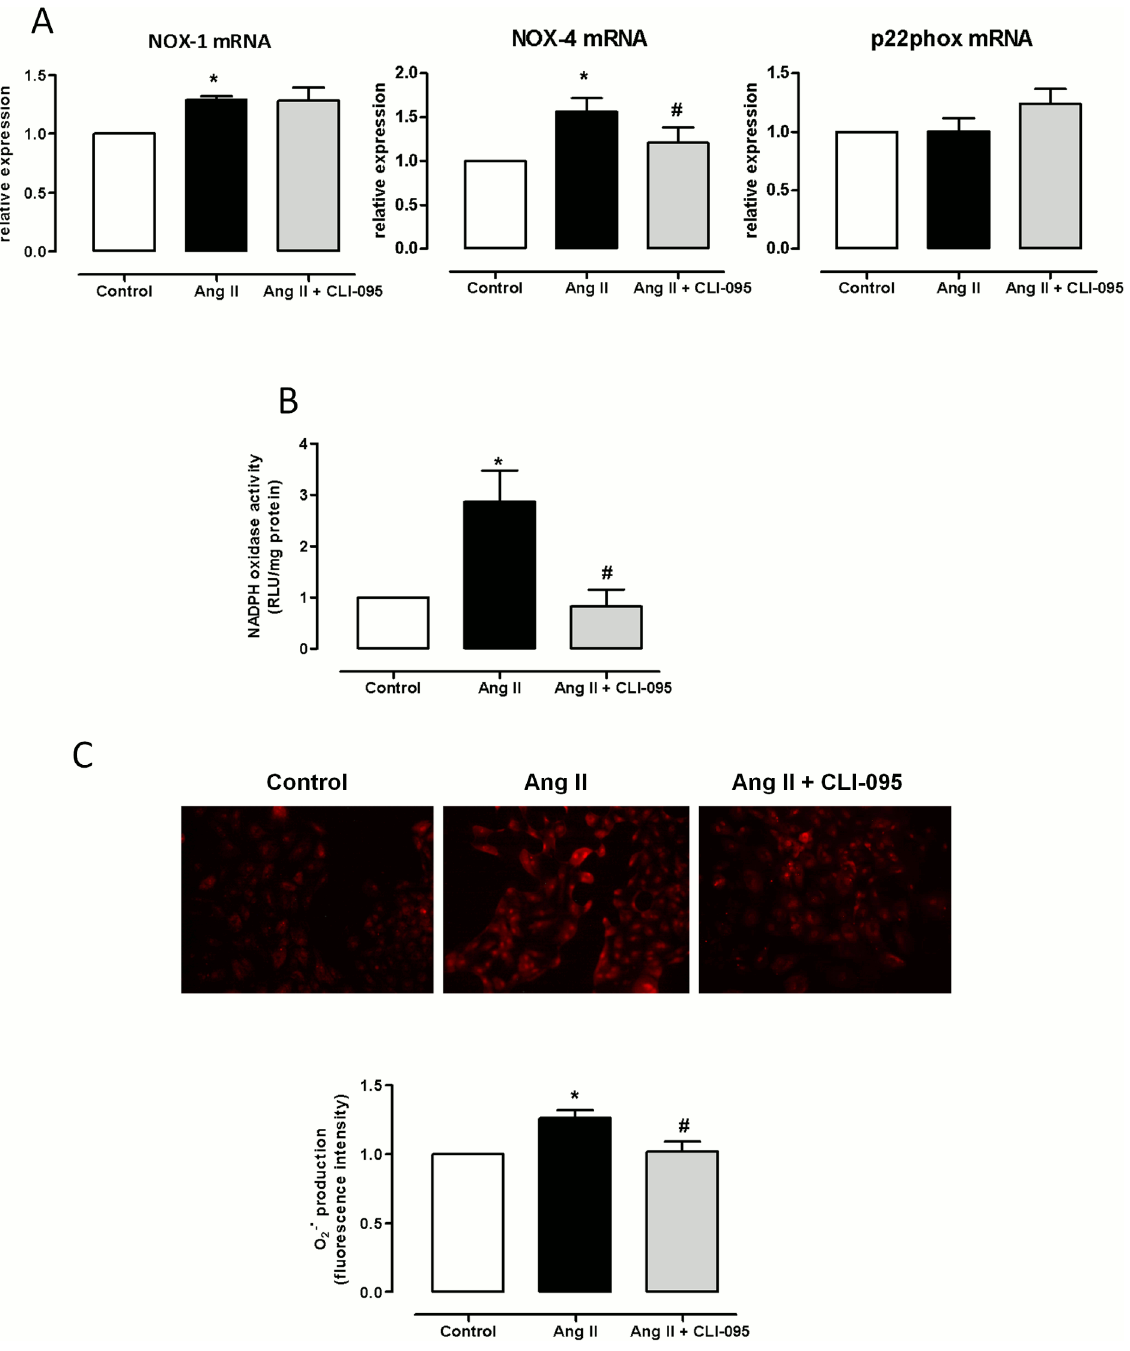
Figure 8. TLR4 inhibition reduces Ang II-induced NAD(P)H oxidase activity and O 2 2 production in VSMC from SHR. Effects of CLI-095 (1 m M, 1 h) on Ang II (100 nM, 2 h)-induced (A) NOX-1, NOX-4 and p22phox mRNA levels, (B) NAD(P)H oxidase activity and (C) O 2 2 N production in SHR VSMCs. The results (mean 6 SEM) are expressed as relative values compared with the control. *P , 0.05 vs. Control, # P , 0.05 vs. Ang II using Student’s t-test or the Mann-Whitney nonparametric test. n=4–6.